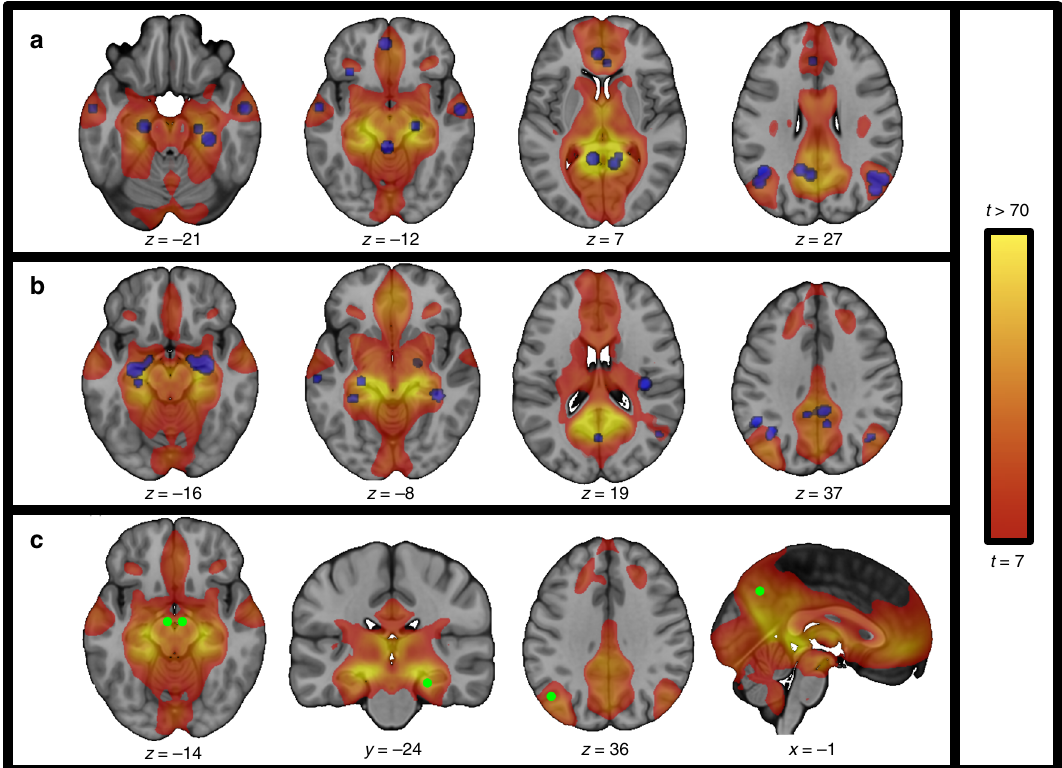
Fig. 5 Memory circuit alignment with other imaging and stimulation modalities. Our human memory circuit derived from amnesia-causing brain lesions aligns well with data from other modalities. Functional connectivity with the subiculum-retrosplenial continuum (See Fig. 3D) de fi nes a brain network that aligns well with neuroimaging correlates of episodic memory based on functional neuroimaging ( a , purple spheres), neuroimaging abnormalities in Alzheimer ’ s disease ( b , purple spheres), and locations where brain stimulation has been reported to enhance memory performance in humans ( c , green